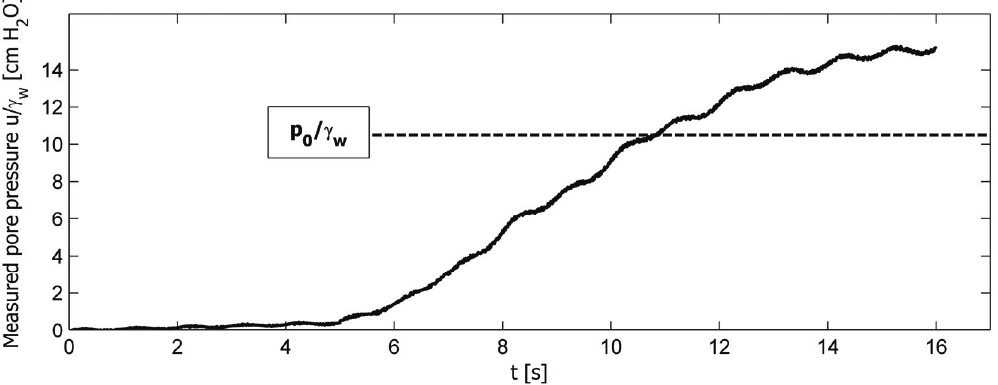
Fig. 2. Pore pressure build-up caused by water